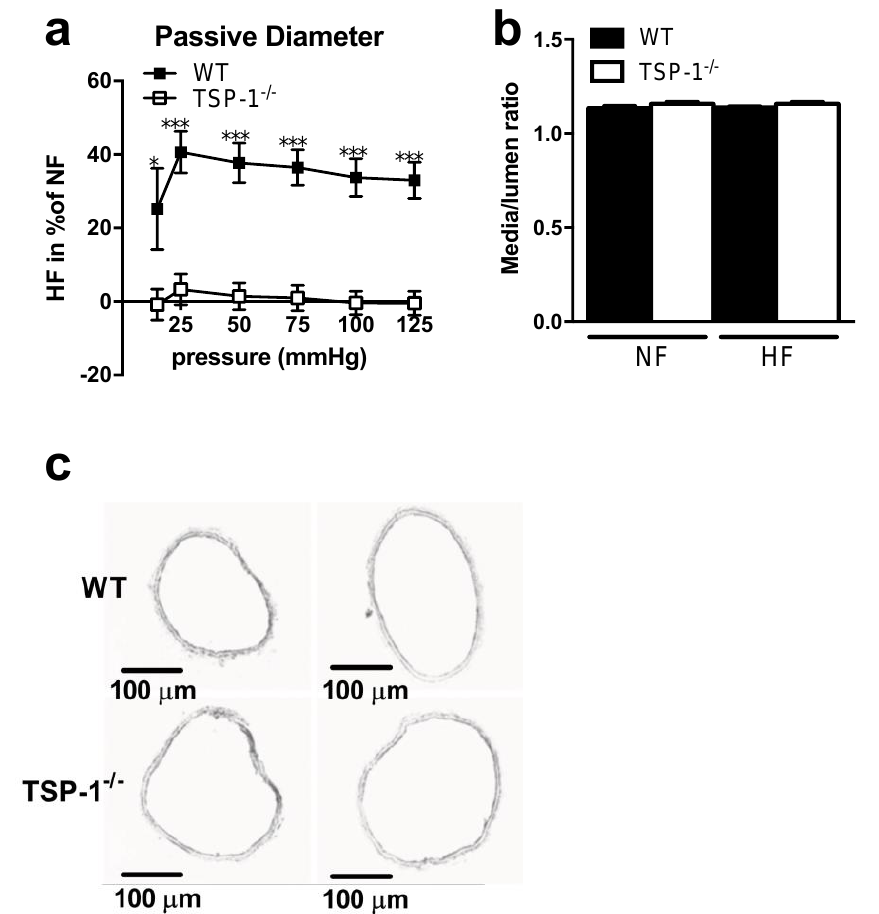
Figure 3. Remodeling study after seven days of chronic increase in blood flow and hydralazine treatment. Graphs show ( a ) the passive diameter of the HF mesenteric arteries in percentage of the NF mesenteric arteries diameter, ( b ) histomorphometry analysis of these mesenteric arteries as media-to-lumen ratio. ( c ) shows representative images ( × 10 magnification, scale bar = 100 µ m). TSP-1 − / − ( n = 10) mesenteric arteries are represented in white and WT ( n = 6) in black. All results are expressed in means ± sem. * p < 0.05, *** p < 0.001, WT vs. TSP-1 − / −